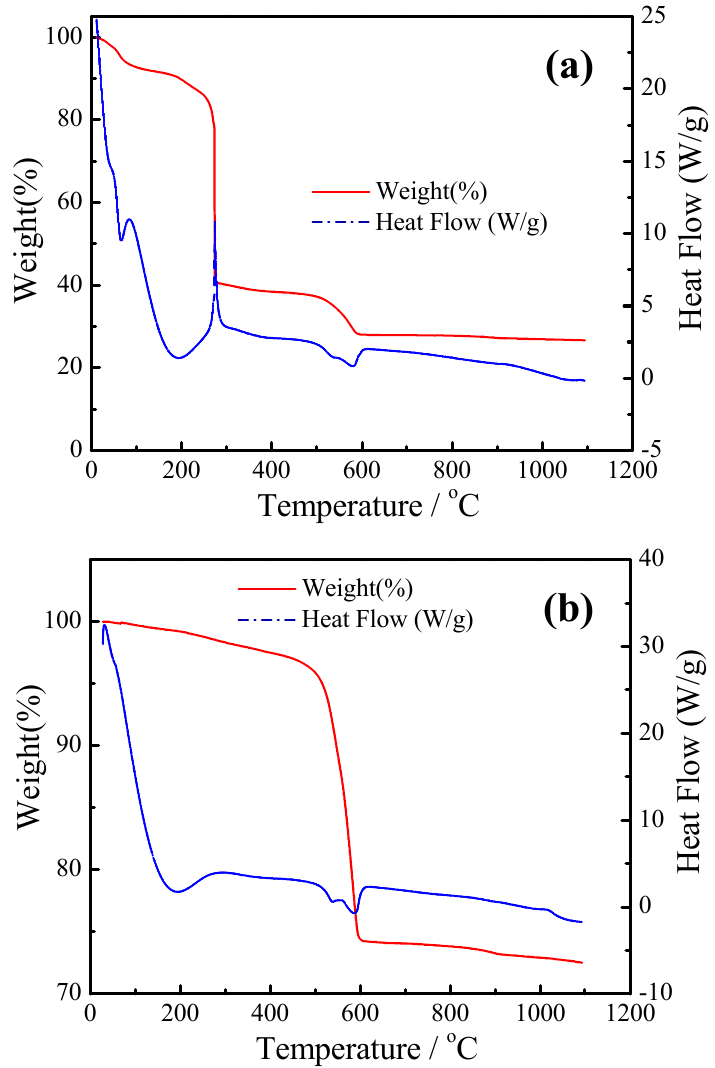
Figure 1. Thermogravimetric Analysis and Differential Scanning Calorimetry (TGA-DSC) plots for the BaCe 0.9 Yb 0.1 O 3 −α precursor before ( a ) and after ( b ) ashing